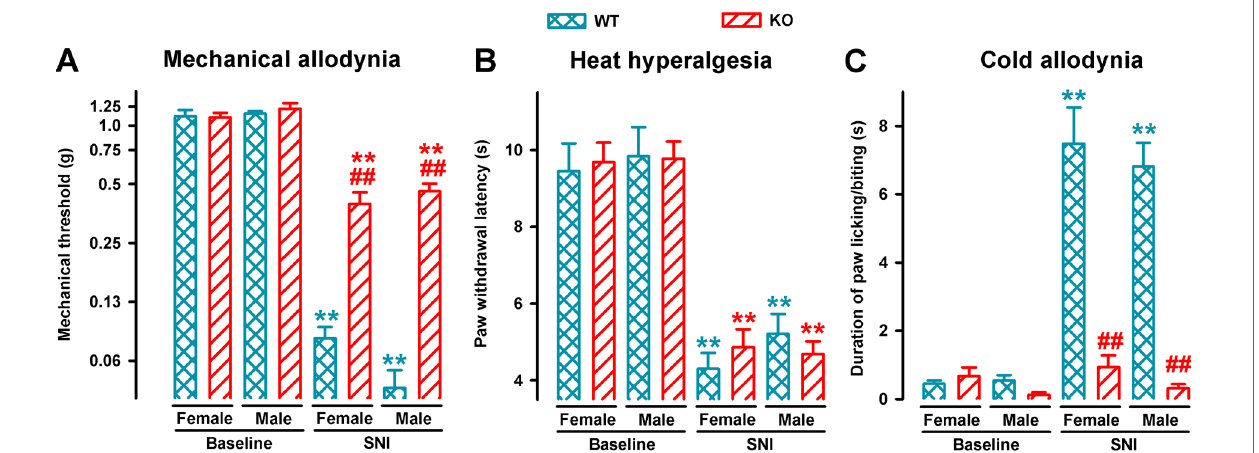
FIGURE 2 | Comparison of SNI-induced neuropathic pain behaviors in female and male WT and σ 1 -KO mice. The von Frey threshold (A) , latency to hind paw withdrawal in the Hargreaves test (B) , and duration of hind paw licking or biting in the acetone test (C) were recorded 1 day before (baseline) and 7 days after surgery in the paw ipsilateral to the surgery. Each point and vertical line represent the mean ± SEM of the values obtained in 8–12 animals. Statistically significant differences between the values on the presurgery (baseline) day and 7 days after SNI in mice of the same sex: ** P < 0.01; and between WT and KO groups of mice of the same sex: ## P < 0.01. There were no statistical differences between values from mice of different sexes under the same experimental conditions (two-way repeated-measures ANOVA followed by Bonferroni test).